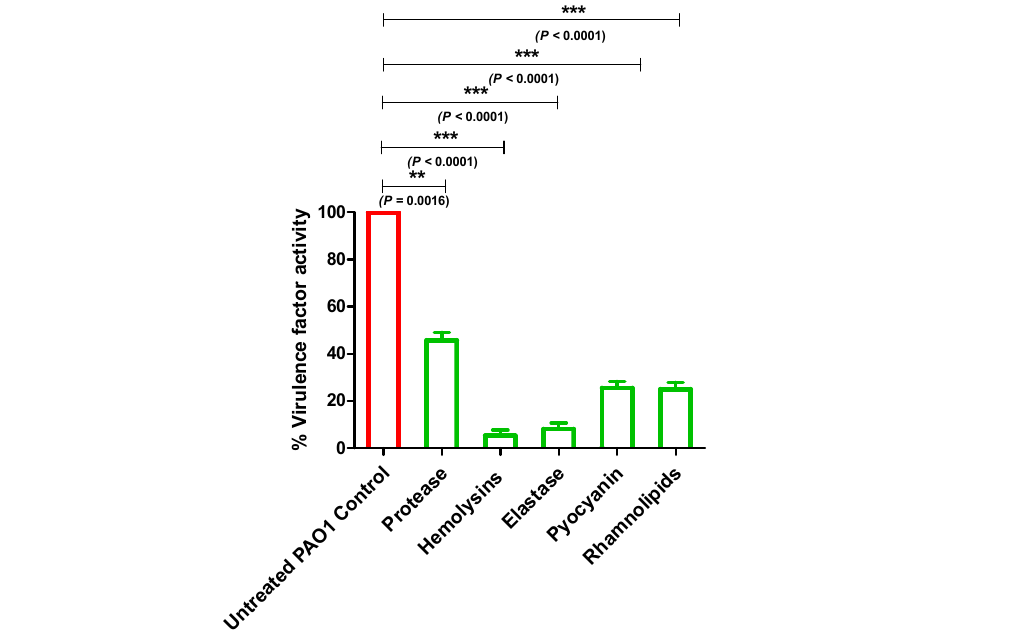
Figure 5. Allopurinol inhibitory effect on P. aeruginosa virulence. Allopurinol at sub-MIC significantly reduced the production of protease, hemolysins and elastase enzymes, pyocyanin pigment, and rhamnolipids. The supernatants of the treated and untreated allopurinol bacteria were used for the assays. Protease activity was assayed by measuring the clear zones around the wells made in skim milk agar plates. Hemolysin activity was assayed spectrophotometrically by measuring hemoglobin absorbance. Elastase activity was measured by the elastin congo red method. Pyocyanin was measured spectrophotometrically at 691 nm, and rhamnolipid was assayed using the oil displacement method by measuring the clearance zone produced by the addition of the supernatant cultures to oil. The data are presented as the percentage change from the untreated P. aeruginosa control .